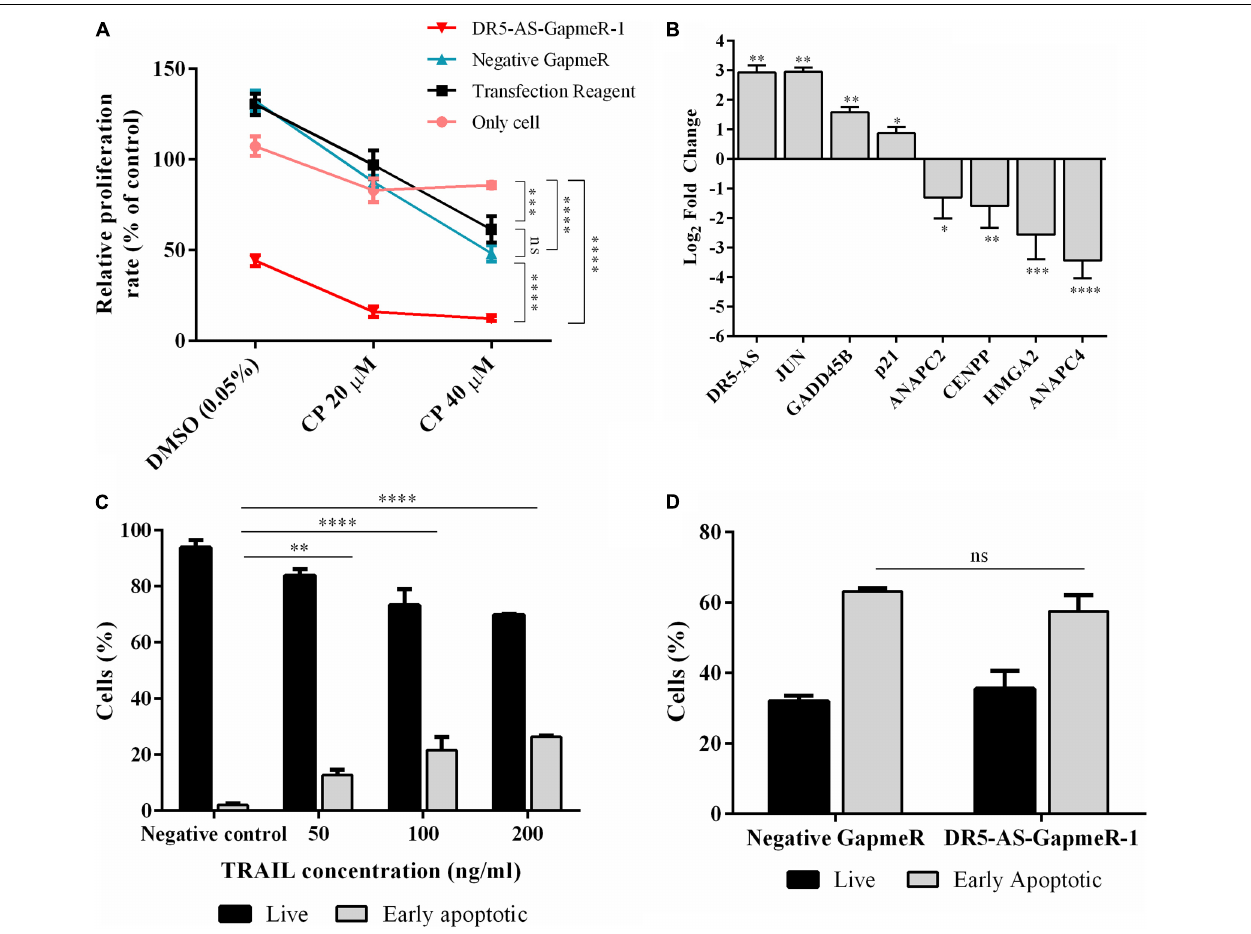
FIGURE 7 | Cisplatin- and TRAIL-induced cellular changes in DR5-AS knockdown HeLa cells. (A) Proliferation rate of cisplatin-treated HeLa cells transfected with DR5-AS GapmeR. HeLa cells were transfected with DR5-AS GapmeR-1 for 72 h and then treated with cisplatin for additional 16 h. Proliferation rate of cells was measured by WST-1 assay. “Only cell” (no transfection), “transfection reagent” (cells transfected with transfection reagent only), and negative GapmeR were used as controls. (B) qPCR analyses of cell cycle-associated genes in cisplatin-treated HeLa cells. HeLa cells were treated with 80 µ M cisplatin for 16 h and qPCR analyses were carried out with total RNAs isolated from control (0.1% DMSO) and cisplatin-treated cells. (C) Dose response of HeLa cells treated with TRAIL for 3 h treatment. (D) Apoptosis rate of HeLa cells after TRAIL treatment. HeLa cells were treated with 200 ng/ml TRAIL for 3 h. The rate of apoptosis was measured by flow cytometry following Annexin V/7AAD staining. ns, non-significant, p > 0.05, ∗ p ≤ 0.05, ∗∗ p ≤ 0.01, ∗∗∗ p ≤ 0.001, and ∗∗∗∗ p ≤